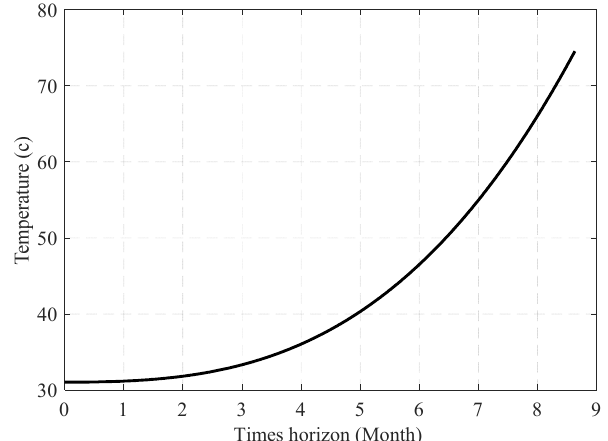
Figure 20. Assumed lubricant temperature (second fault scenario).